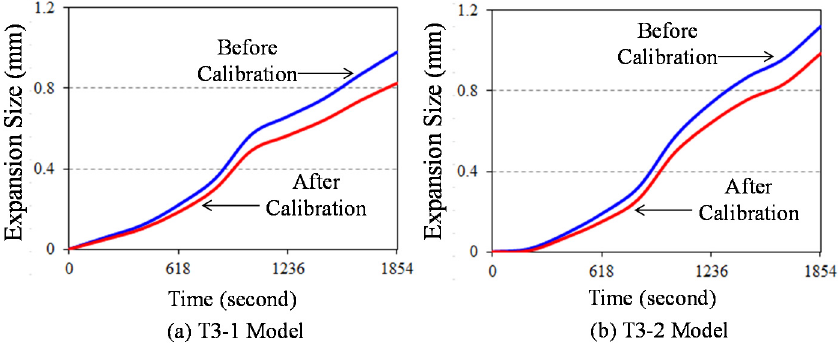
Figure 8. Time versus expansion size resulting curves.